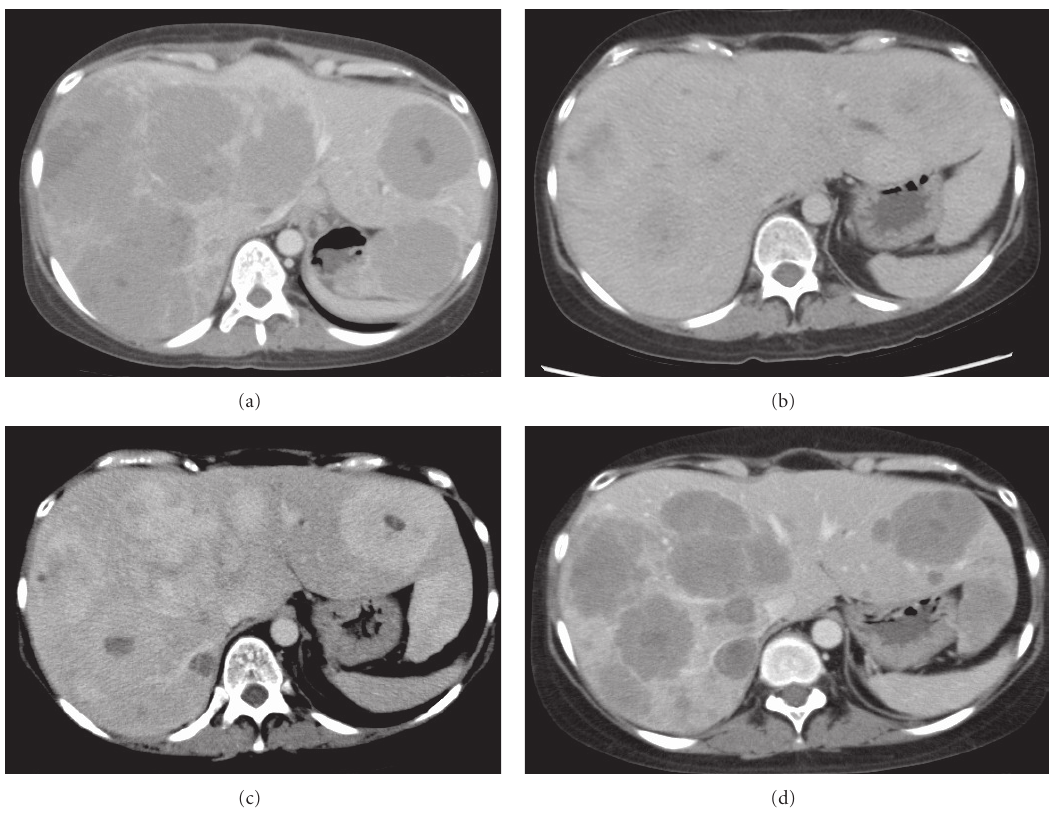
Figure 2: (a) Computed tomography (CT) before first temsirolimus administration. There are multiple metastatic tumors in liver. All tumors are enhanced weakly (64 Hounsfield units). (b) CT 2 months after temsirolimus administration. Most tumors shrink. (c) CT 5 months after temsirolimus administration. Metastatic tumors grow again. All tumors are enhanced strongly (137 Hounsfield units). (d) CT 3 weeks after sunitinib readministration. All tumors turned to be hypovascular again (67 Hounsfield